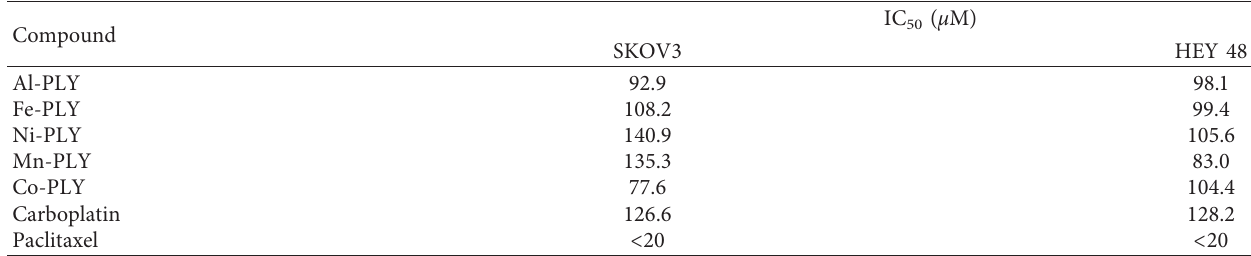
Figure 2: Cell viability measurement by MTT assay. (a) SKOV3 and (b) HEY A8 cell lines were treated with metal-PLY complexes for 24 h. Paclitaxel and carboplatin were added to cells as positive controls. All samples were dissolved in cell media containing 3.75% DMSO by volume for complete dissolution. Table 1: Cytotoxicity levels of metal-PLY complexes in two kinds of ovarian cancer cells.